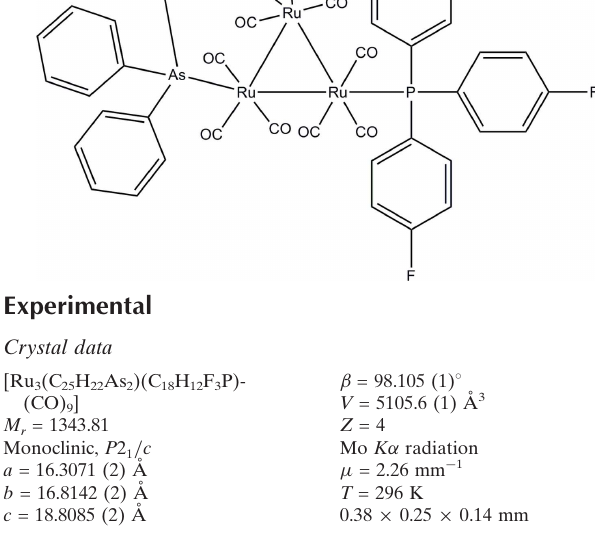
Bruker SMART APEXII CCD area-detector diffractometer Absorption correction: multi-scan ( SADABS ; Bruker, 2005)